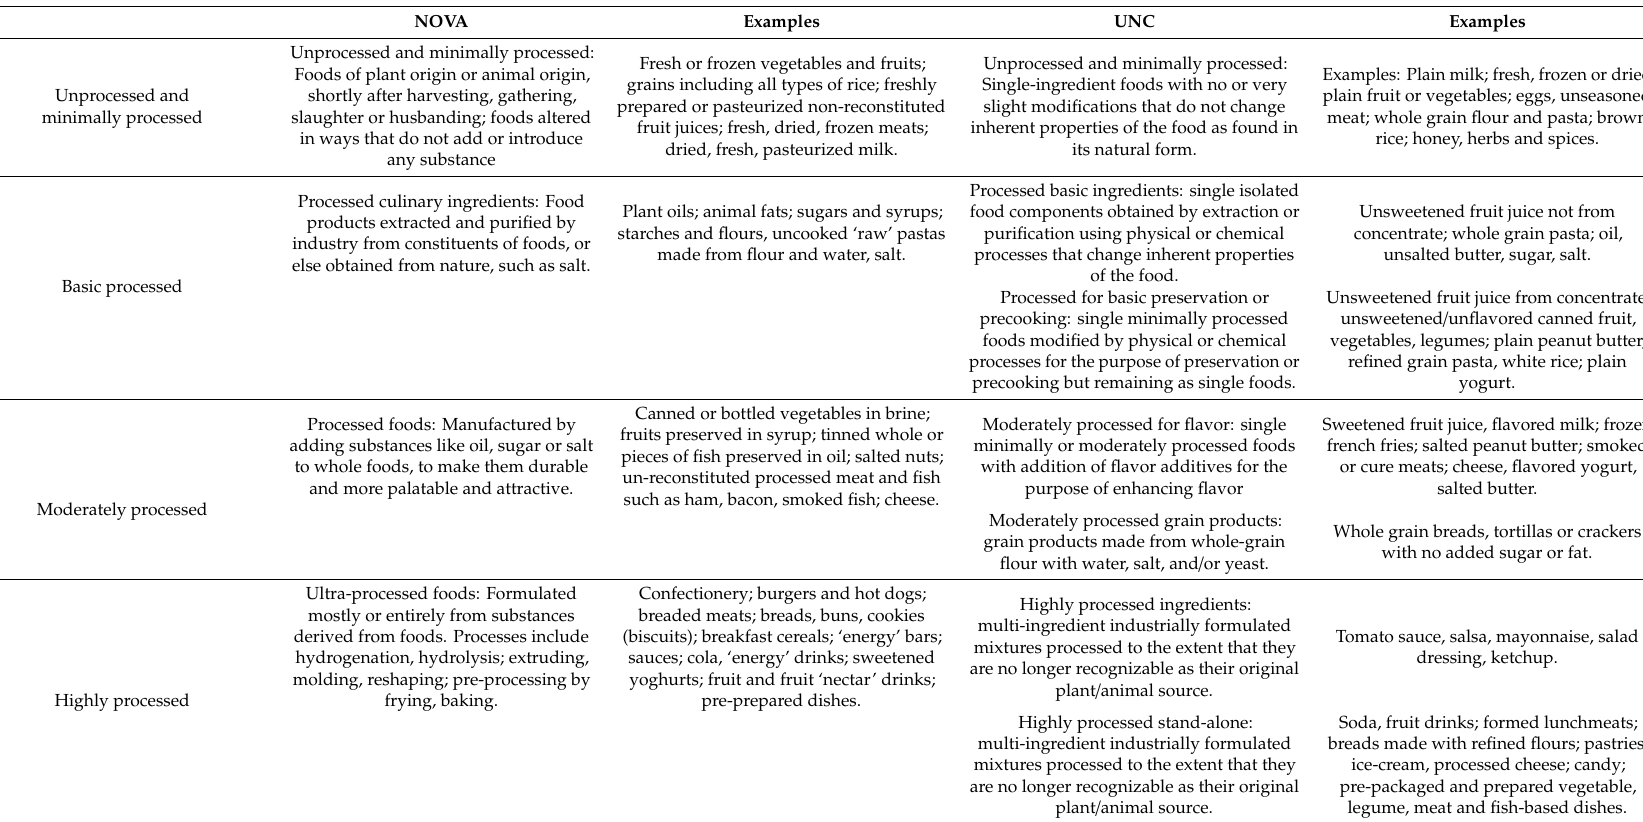
Table 1. Category definitions and criteria for classifying foods and beverages based on degree of industrial food processing according to the Nova [12] and UNC a [13] systems NOVA Examples UNC Examples